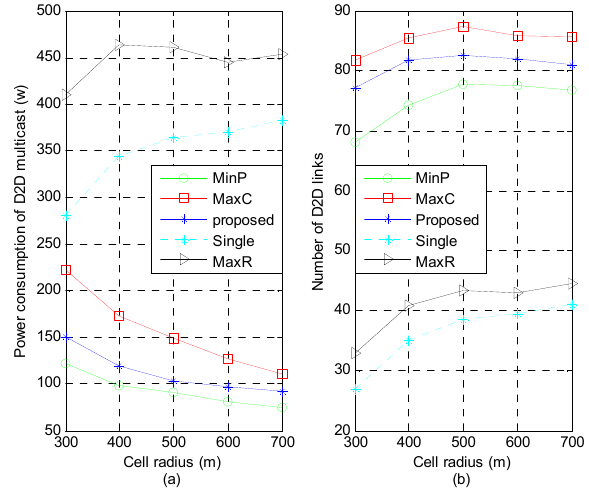
Figure 4. Power consumption and number of D2D links versus cell radius: ( a ) Impact of cell radius on power consumption; ( b ) Impact of cell radius on system capacity.